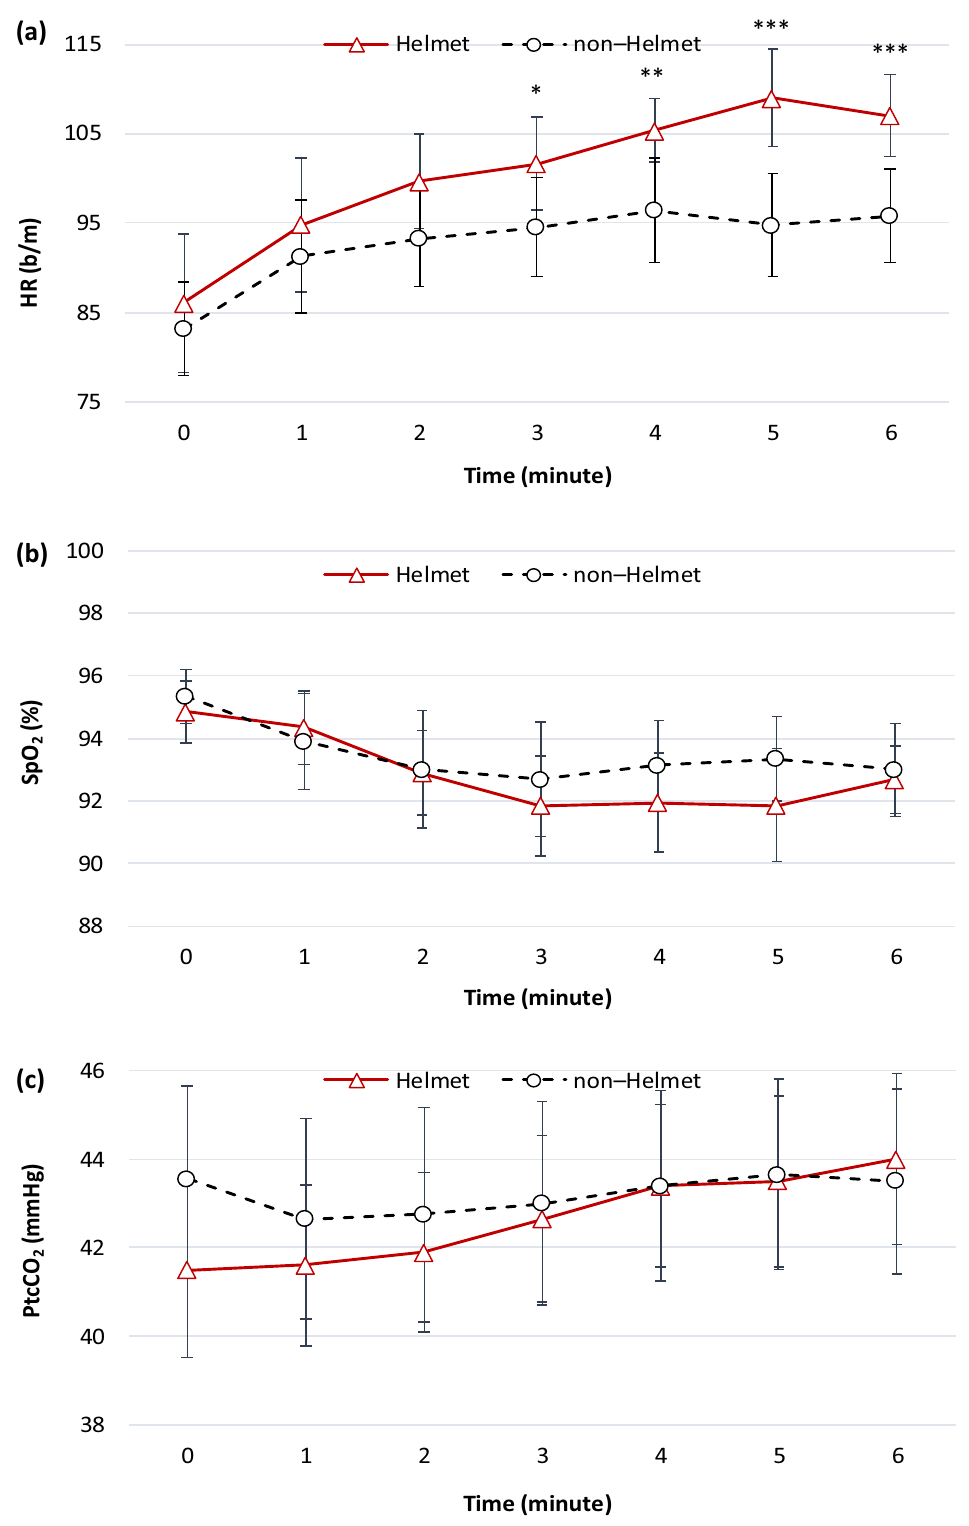
Figure 1. Physiological trends for ( a ) heart rate (HR), ( b ) oxygen saturation (SpO 2 ), and ( c ) transcutaneous carbon dioxide tension